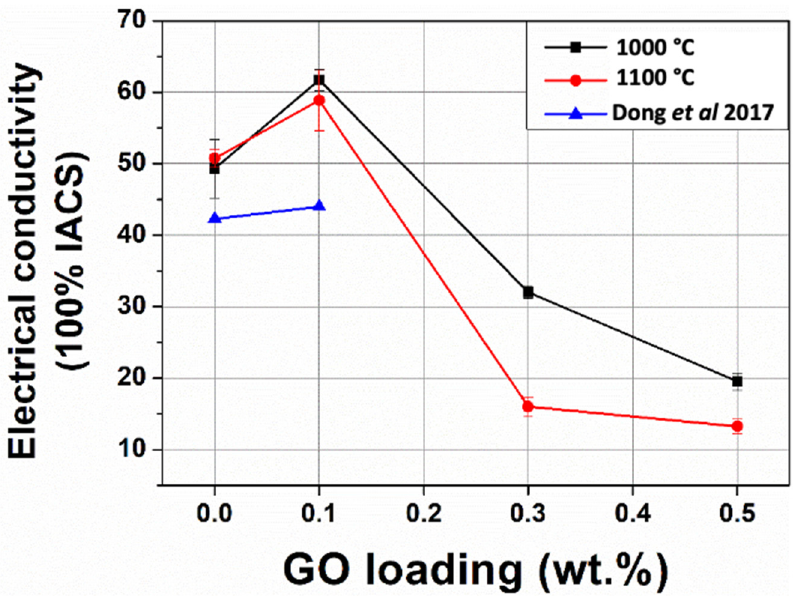
Figure 9. The measured electrical conductivity of samples as function of GO loading and sintering temperature. Additionally, shown are the conductivities reported in [8].